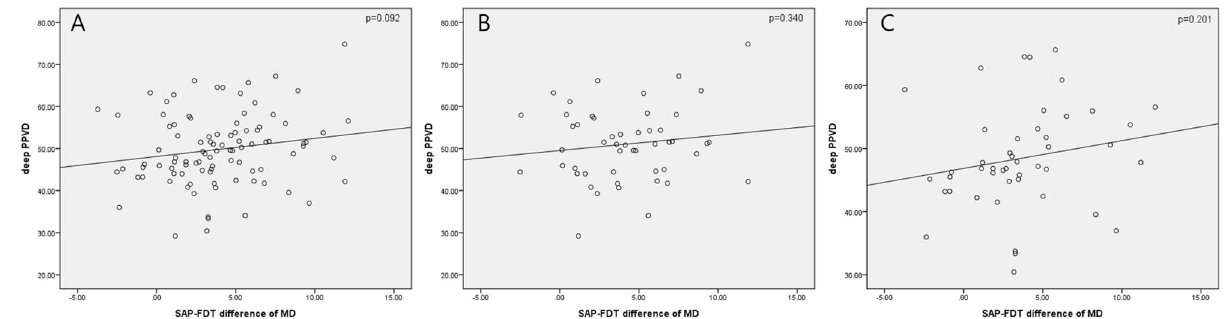
Figure 1. Scatterplot between SAP–FDT difference of MD and deep layer of peripapillary vessel density. Difference of MD between VFs tends to decrease, as VD decreases in whole group ( A ), in peripheral nasal step (PNS) group ( B ), and in parafoveal scotoma group (PFS) ( C ), without statistical